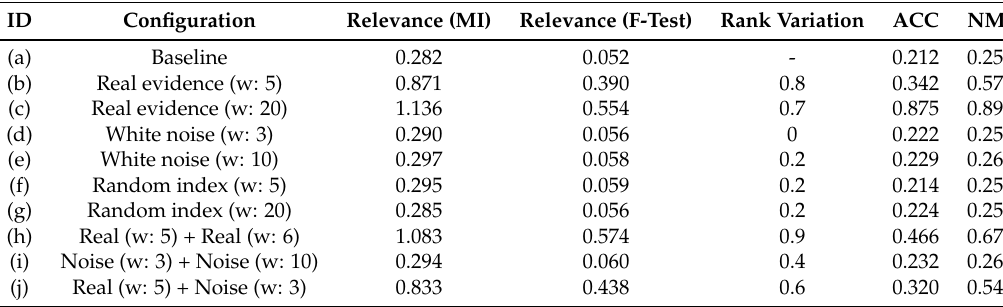
Table 3. Twenty newsgroup dataset results for the 20-newsgroup experiments’ real corresponding evidence represents supersets of the original labelset. The width 5 real evidence corresponds to aggregating labels into Comp(uters), Rec(reational), Sci(ence), Talk, and Misc. groups. For width 6 evidence, we aggregate the labelset into 6 groups of sport, politics, religion, vehicles, systems, and science. The 20-width evidence represents the labelset of 20